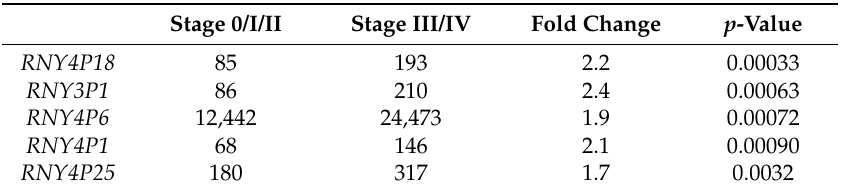
Table 4. Differentially expressed YRNAs ( p < 0.05). Counts were normalized per million reads. YRNAs validated are depicted in